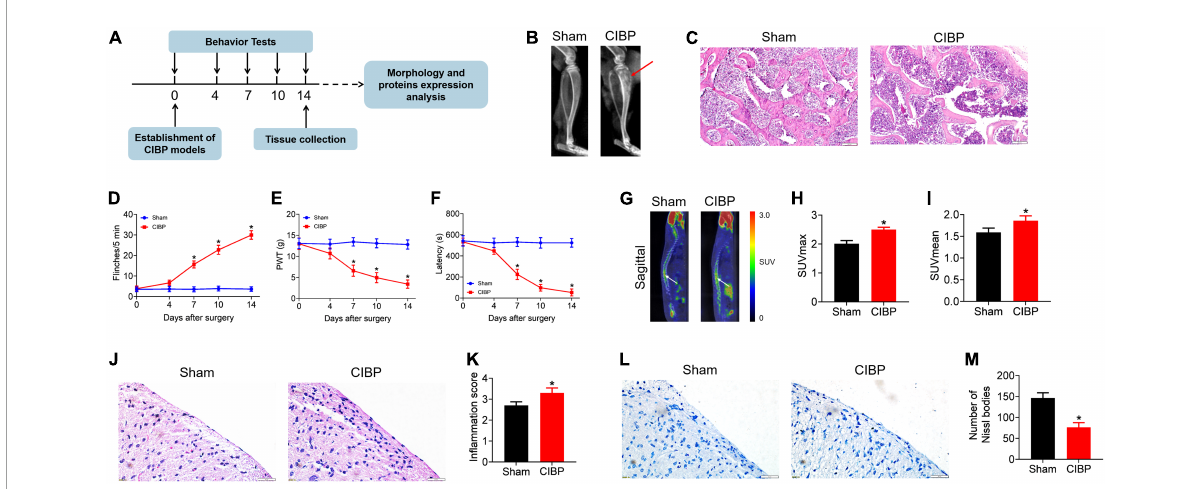
FIGURE1 Validation of the cancer-induced bone pain (CIBP) rat model and the characterization of spinal functional changes. (A) Schematic diagram of the experimental procedures. On day 0, the CIBP model was established. On days 0, 4, 7, and 14 after surgery, the behavioral tests including spontaneous flinches record, PWT value test, and latency to fall assay were performed. On day 14, X-ray scan, PET scan, histology staining, Western blotting, and LC-LC/MS assay were performed after behavioral tests. (B) Representative radiographs of the ipsilateral tibia from sham and CIBP rats on day 14. The red arrows indicate areas of bone destruction in CIBP rats ( n = 9 per group). (C) Representative images of H&E staining of tibial sections from sham and CIBP rats ( n = 3 per group). Scale bars: 100 µ m. (D) The numbers of spontaneous flinches of sham and CIBP rats. Data were expressed as the mean ± SEM ( n = 9 mice/group). * p < 0.05 vs. sham group. (E) PWT values were assessed by von Frey filaments with the up-and-down method. Data were expressed as the mean ± SEM ( n = 9 mice/group). * p < 0.05 vs. sham group. (F) The latency to fall of accelerated rotarod motor test of sham and CIBP rats. Data were expressed as the mean ± SEM ( n = 9 mice/group). * p < 0.05 vs. sham group. (G–I) Representative 18 F-FDG PET images in spinal cord (sagittal) (G) . SUVmax (H) and SUVmean (I) of the spinal cord from sham and CIBP rats. Data were expressed as the mean ± SD ( n = 3 mice/group). * p < 0.05 vs. sham group. (J–K) Representative images (J) and quantitative analysis (K) of H&E staining of the spinal cord. Scale bar: 20 µ m. Data were expressed as the mean ± SD ( n = 3 mice/group).